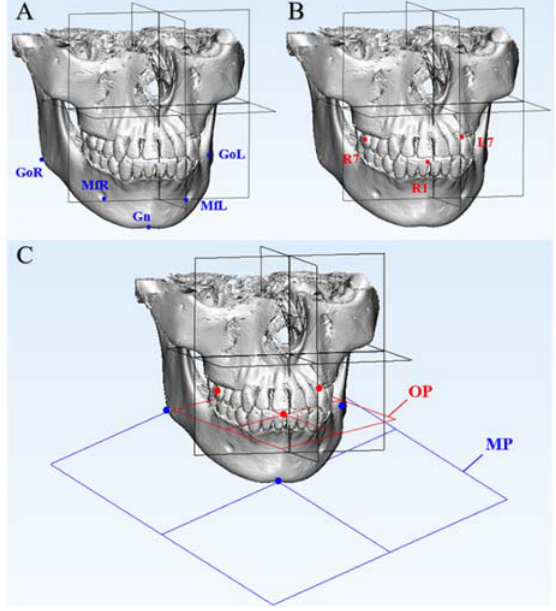
Figure 5. Mandibular measurement landmarks and planes. ( A ) The blue points are five mandibular skeletal landmarks: MfL, MfR, GoL, GoR and Gn. ( B ) The red points are three mandibular dental landmarks: R1, L7 and R7. ( C ) The blue plane is the mandibular plane constructed by Gn, GoL and GoR. The red plane is the occlusal plane constructed by R1, L7 and R7. The schematic diagram of the process of this method is shown in Figure 6.